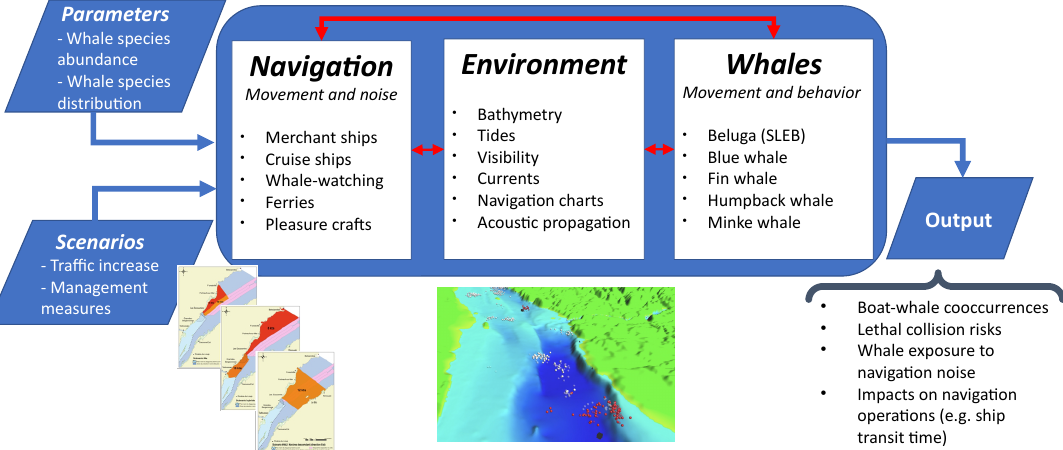
Figure 1. Overview of 3MTSim structure, inputs, and outputs. The simulator represents the main components of maritime traffic and whale movements in the St. Lawrence Estuary and the Saguenay River during the peak season of boat–whale interactions, from May to October. Ships and whale agents could move freely on a continuous space with their positions being updated every minute. The environment submodel was characterized by attributes (e.g., tides, visibility extent) and layers of information such as bathymetry and the nature of sediments, with a 100 m spatial resolution. A large amount of quality data were used to implement, calibrate and validate this ABM (see Table 1). For whale-watching excursions, data included interviews with captains and over 2100 sampled excursions for which GPS tracks, boat activities and neighbourhood composition (i.e., boats and whales) were available. Regarding the model of whale movements, the data used included VHF and shore-based tracking data, as well as transect-derived